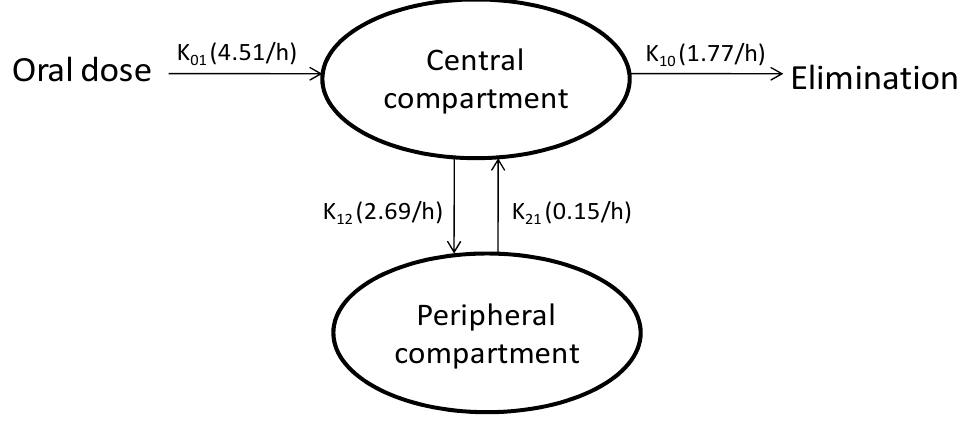
Figure 7. Pharmacokinetic model developed to describe the plasma concentration-time profile in human volunteers after oral dosing of